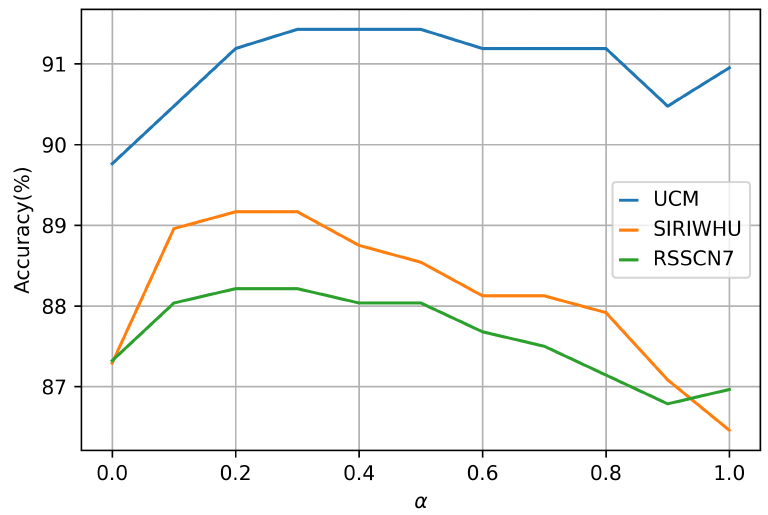
Figure 13. The diagram of influence of α